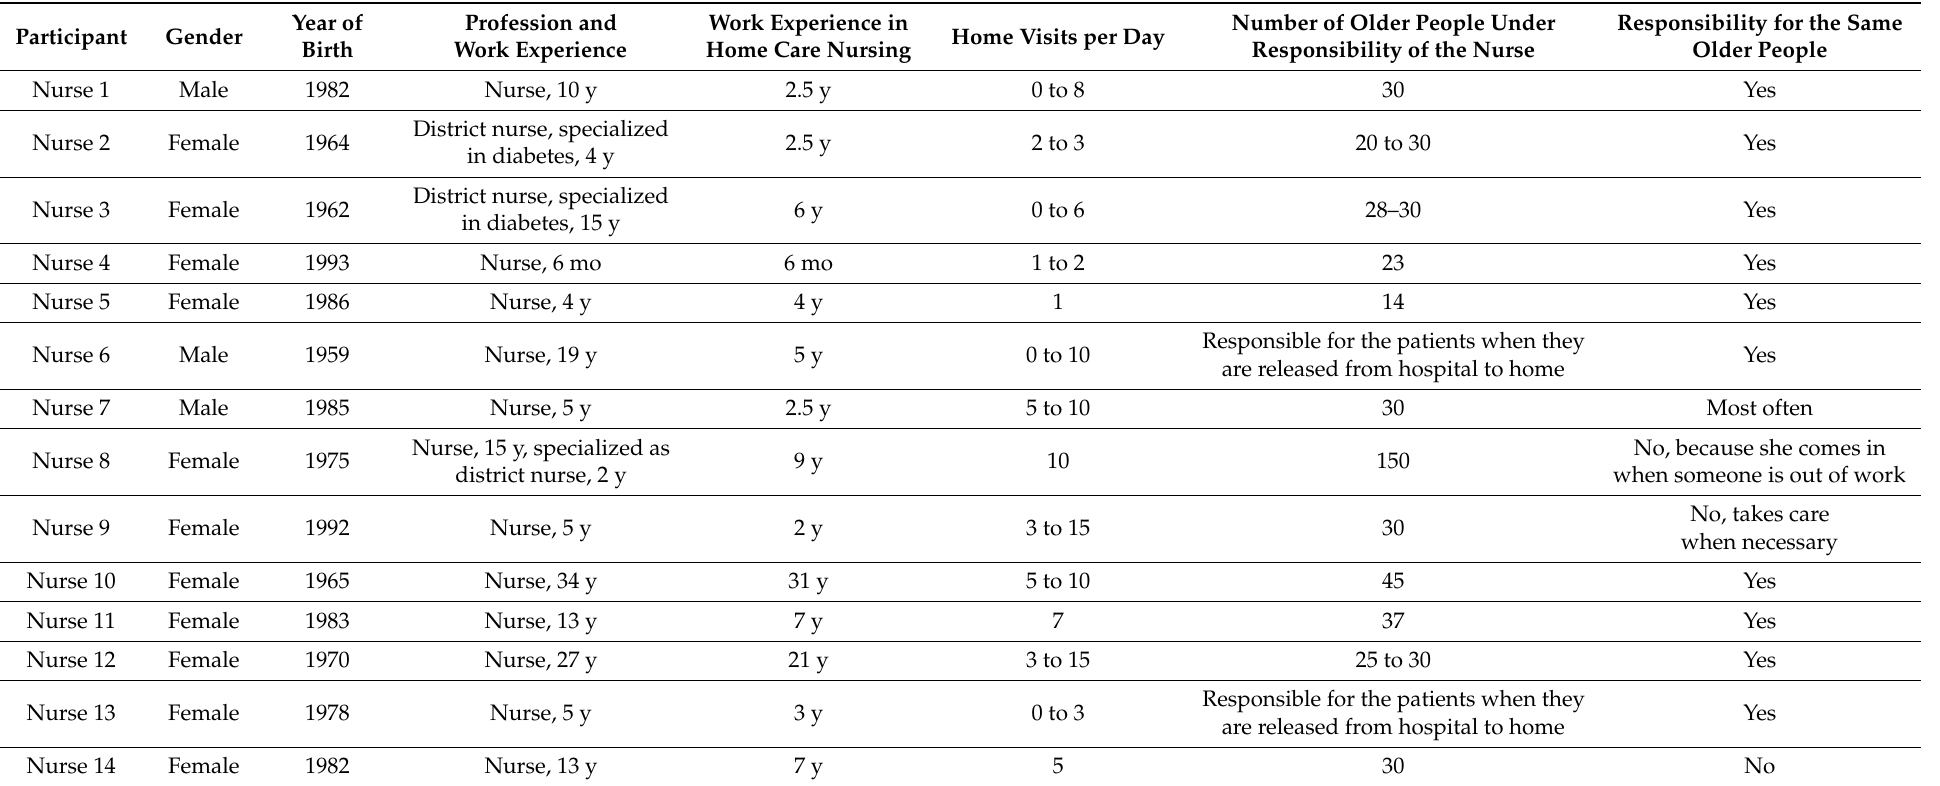
Table 3. Profile of